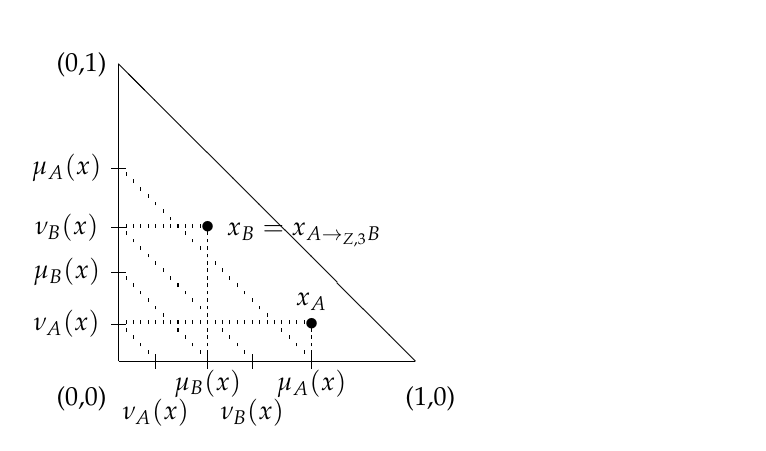
Figure 3. Geometrical interpretations of elements x A , x B and x A